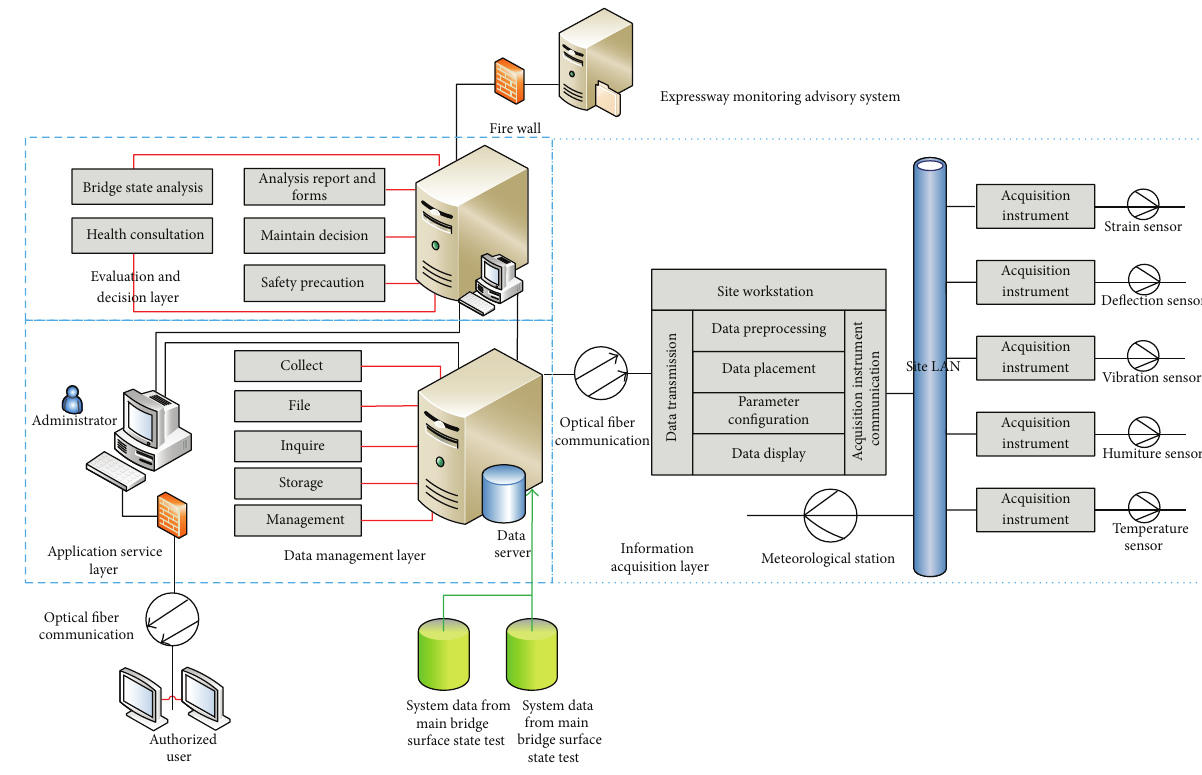
Figure 2: Overall workflow of the